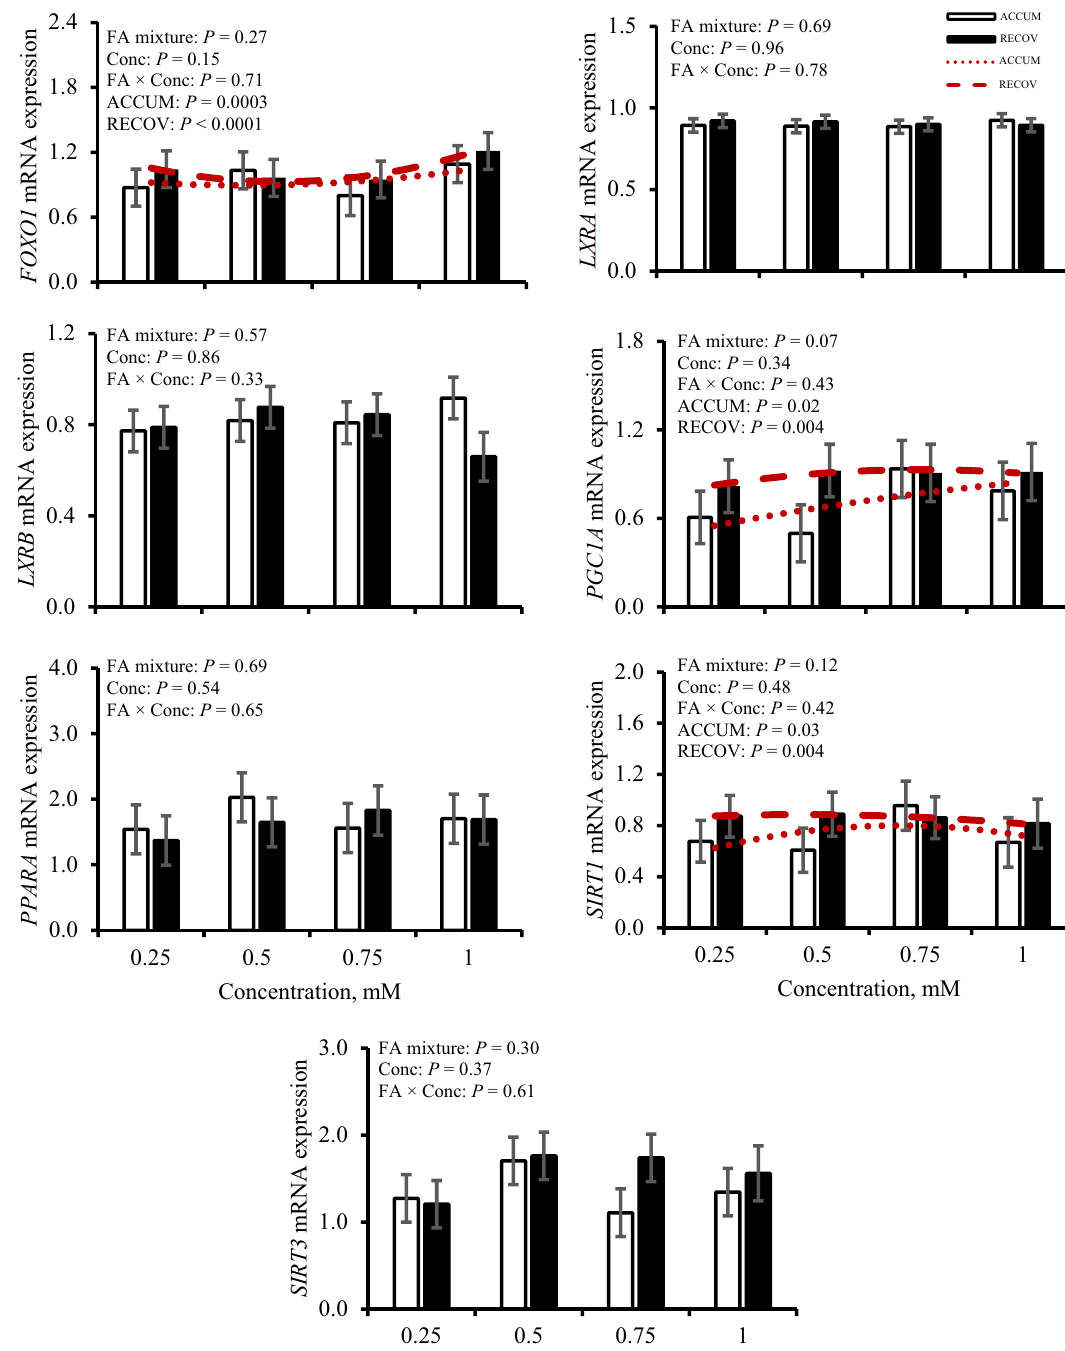
Figure 4. Gene expression of transcription factors forkhead box O1 ( FOXO1 ), liver X receptor α ( LXRA ), liver X receptor β ( LXRB ), peroxisome proliferator-activated receptor gamma coactivator 1-alpha ( PGC1A ), peroxisome proliferator-activated receptor α ( PPARA ), sirtuin 1 ( SIRT1 ), and sirtuin 3 ( SIRT3 ) in response to fatty acid mixture representing liver lipid accumulation (ACCUM; open bars and dotted line) and fatty acid mixture representing liver lipid clearing (RECOV; closed bars and dashed line) at different concentrations in primary bovine hepatocytes. Data is presented as least squares mean ± standard error of the means. Quadratic relationships are displayed if P ≤ 0.15 for a main